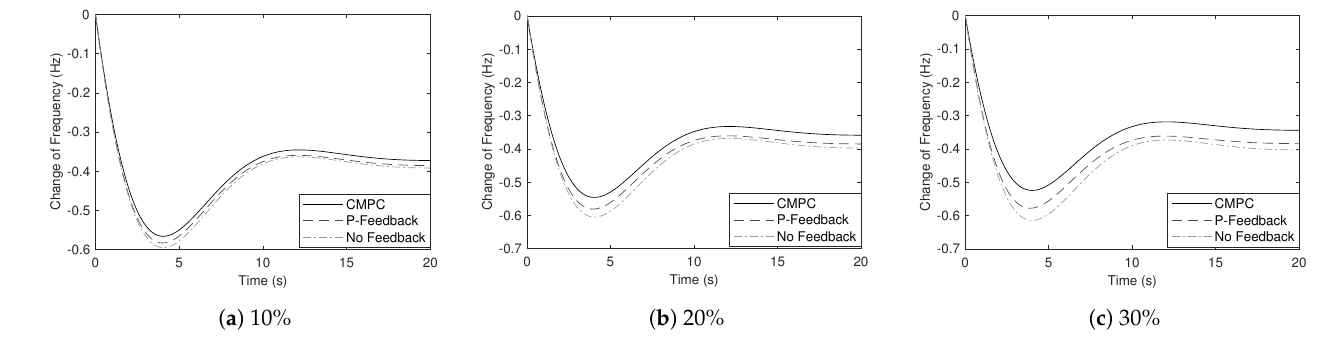
Figure 7. System frequency response under a power loss of 2 GW. The load response is exhibited in Figure 8. The better NADIR response comes from a larger contribution of loads to reestablish the power balance. It is important to note that the SST control leads to a load response that is superior to the proportional control, which emphasizes the optimality of the proposed approach that translates into a larger and faster power response from loads.